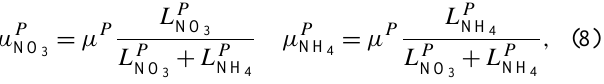
Figure 2. Reduction of growth rate when the mixed layer depth exceeds the euphotic depth for nanophytoplankton (continuous line) and diatoms (dashed line). Depth corresponds to (cid:49)Z